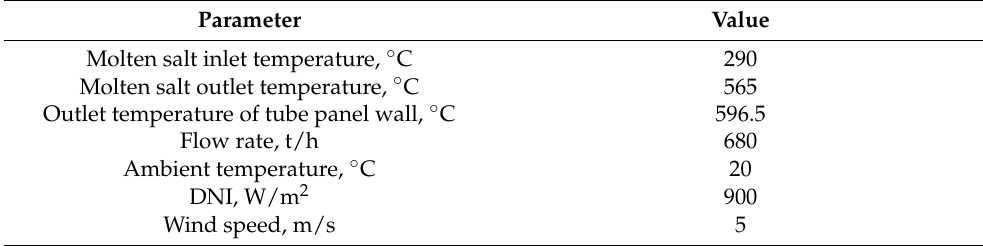
Table 3. The main parameters of the receiver under full load